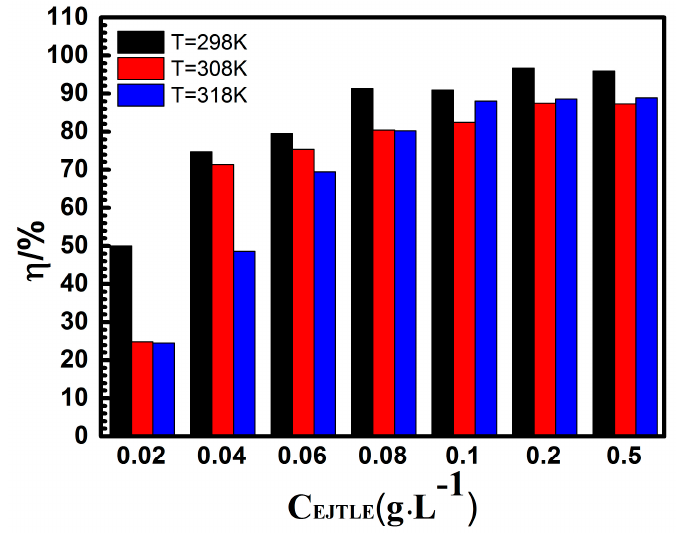
Figure 5. The equivalent circuit model used to fit the electrochemical impedance spectroscopy (EIS) data.